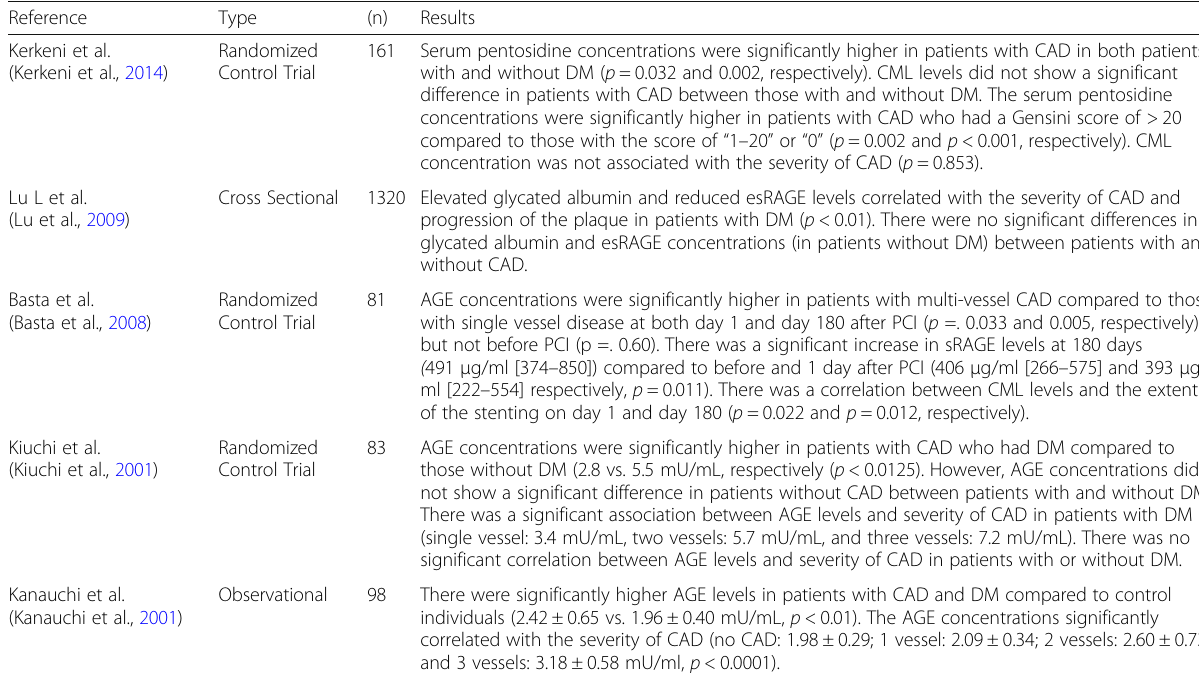
Table 1 The advanced glycation end products (AGEs) and severity of coronary artery disease (CAD)